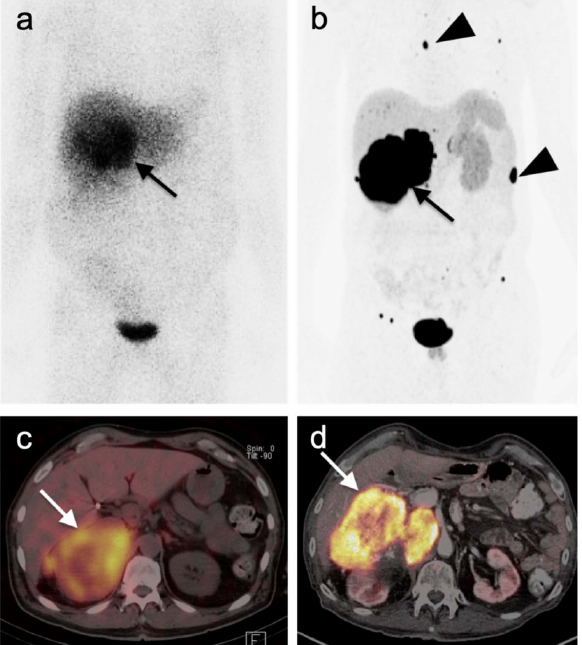
Figure 43. Pheochromocytoma. (( a , c ), left panels) [ 123 I]I-MIBG. Anterior planar imaging of the chest and abdomen ( a ) and an axial SPECT/CT of the upper abdomen with an MIBG scan shows prominent uptake in a large right pheochromocytoma (white arrows). (( b , d ), right panels) [ 64 Cu]Cu- DOTA-TATE (Detectnet ® PET-CT performed several years later in the same patient. ( b ) Upper right is a MIP image of the PET-CT scan, and the right lower image is the corresponding axial PET-CT image showing intense uptake in the mass, which has increased in size (arrows). The patient also has scattered additional foci of activity on the MIP PET image (representative lesions with black arrowheads) that were bone